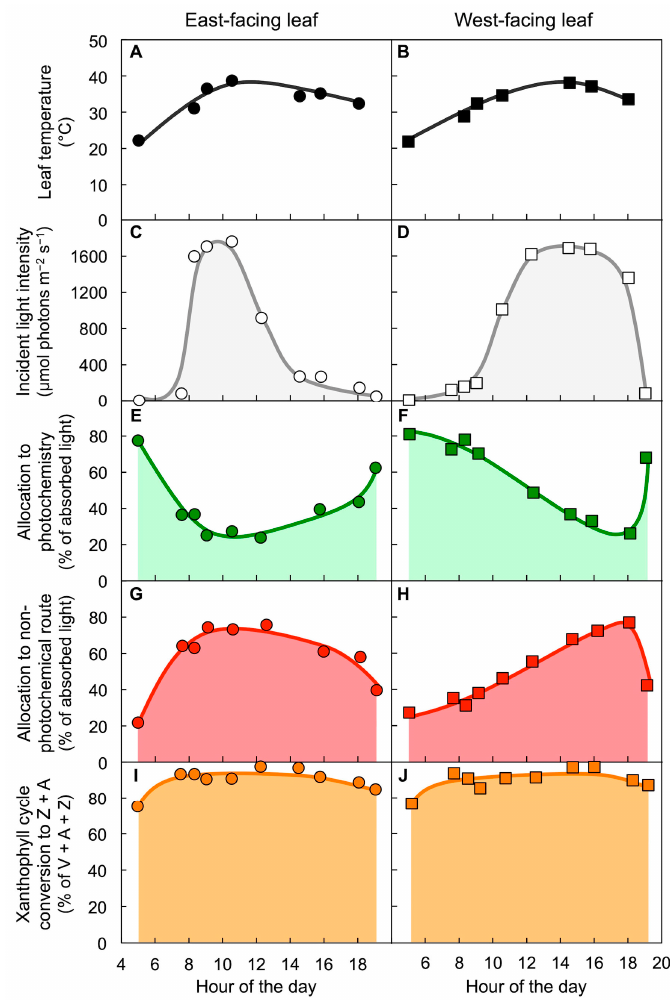
Figure 17. Diurnal characterization of ( A , B ) leaf temperature, ( C , D ) light incident on the upper leaf surface, ( E , F ) percentage of absorbed photons allocated to photochemistry (quantified from chlorophyll fluorescence as photosystem II efficiency), ( G , H ) percent of absorbed photons allocated to the regulated non-photochemical route (derived from maximal photosystem II efficiency as quantified via chlorophyll fluorescence), and ( I , J ) percent of the xanthophyll cycle present as zeaxanthin and antheraxanthin (Z + A) in east-facing ( A , C , E , G , I ) or west-facing ( B , D , F , H , J ) leaves of Yucca brevifolia growing in the Mojave desert on a hot day during summer. V = violaxanthin. Data are from Barker et al. [45].